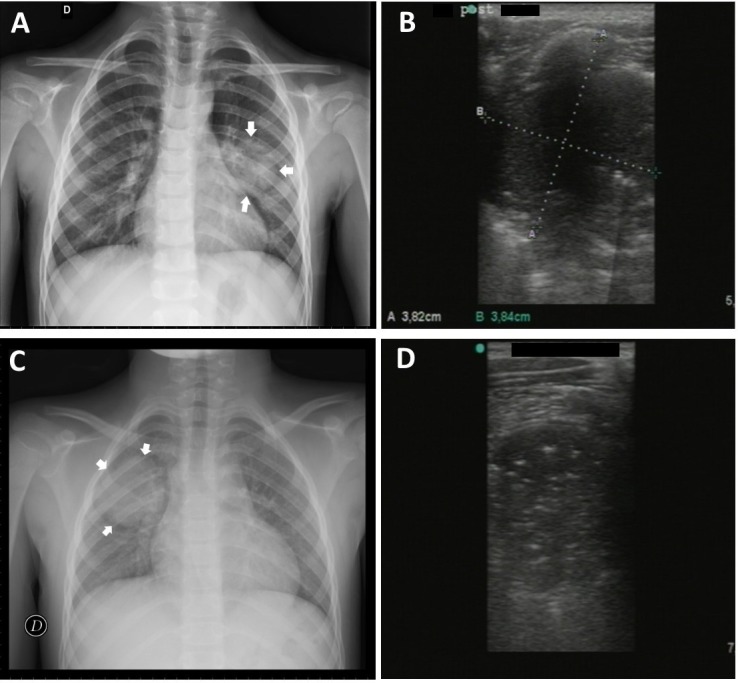
Round pneumonia.Case 1. 5 year old male with evidence of round pneumonia by chest X-ray in middle region of the left lung (A) duly detected by lung ultrasound (B) Case 2. 8 year old male with round pneumonia in middle/upper region of right lung by chest rx (C) and corresponding ultrasound image (D).